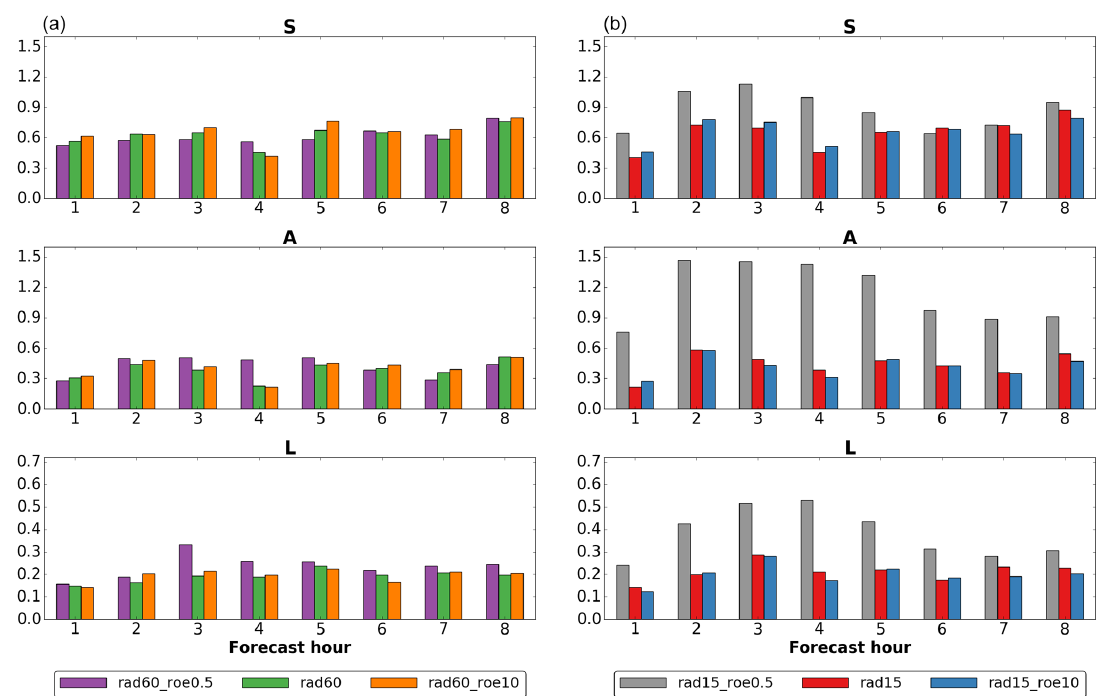
Figure 10. As in Fig. 5 but considering (a) experiments rad60_roe0.5 (violet), rad60 (green) and rad60_roe10 (orange), and (b) experiments rad15_roe0.5 (grey), rad15 (red) and rad15_roe0.5 (blue).